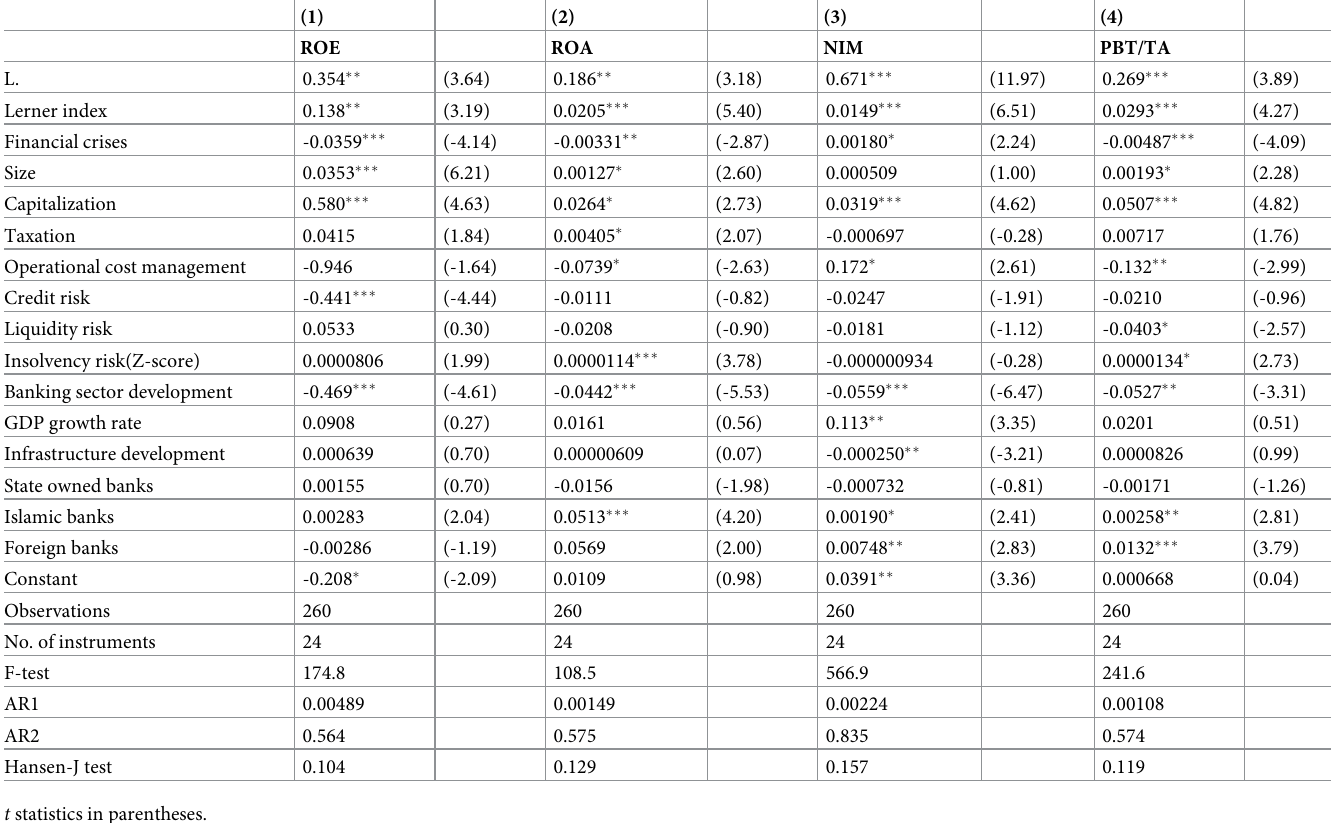
Table 7. When the competition is measured through the Lerner